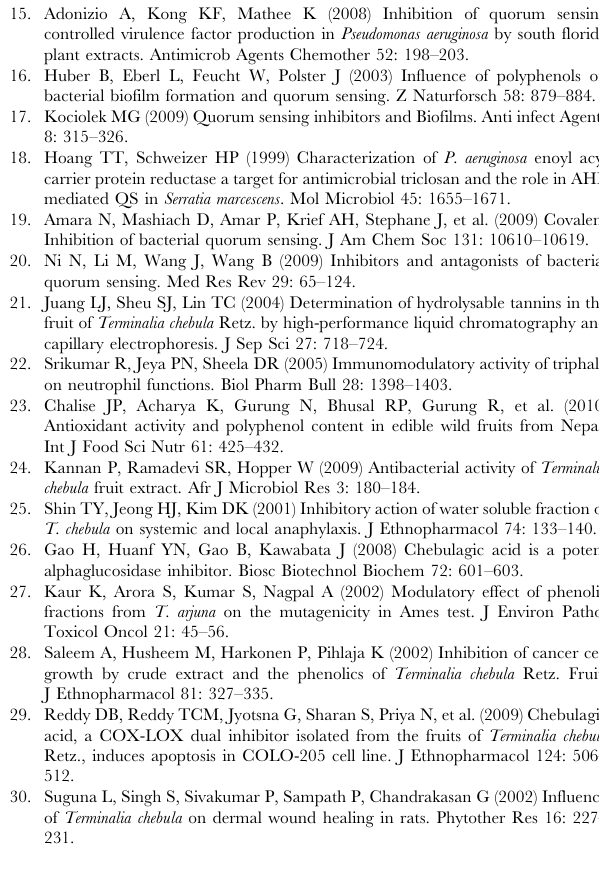
(* , p , 0.05, ¥ , p , 0.001 ). Bars indicates standard deviations for triplicate sets of experiments. (TIF) Figure S3 Effect of F7(1–10 mg/ml) on alginate content in biofilms of P. aeruginosa PAO1. (TIF) Figure S4 ESI-MS analysis of AHLs extracted from P. aeruginosa PAO1 A) untreated B) treated with 0.5 mg/ml of F7. (TIF) Figure S5 Effect of F7 (0–1.25 mg/ml) on growth of P. aeruginosa PAO1. (TIF) Table S1 Compound(s) isolated from T. chebula fruit [35].